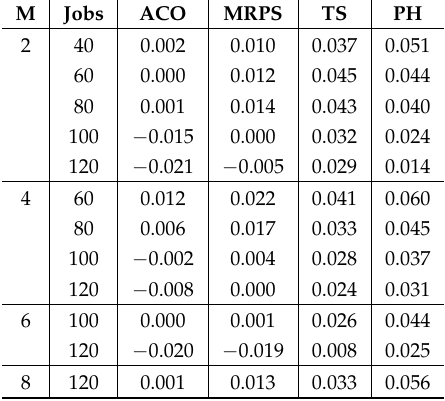
Table 11. The apd values for the large problems among SASCA and the other methods.